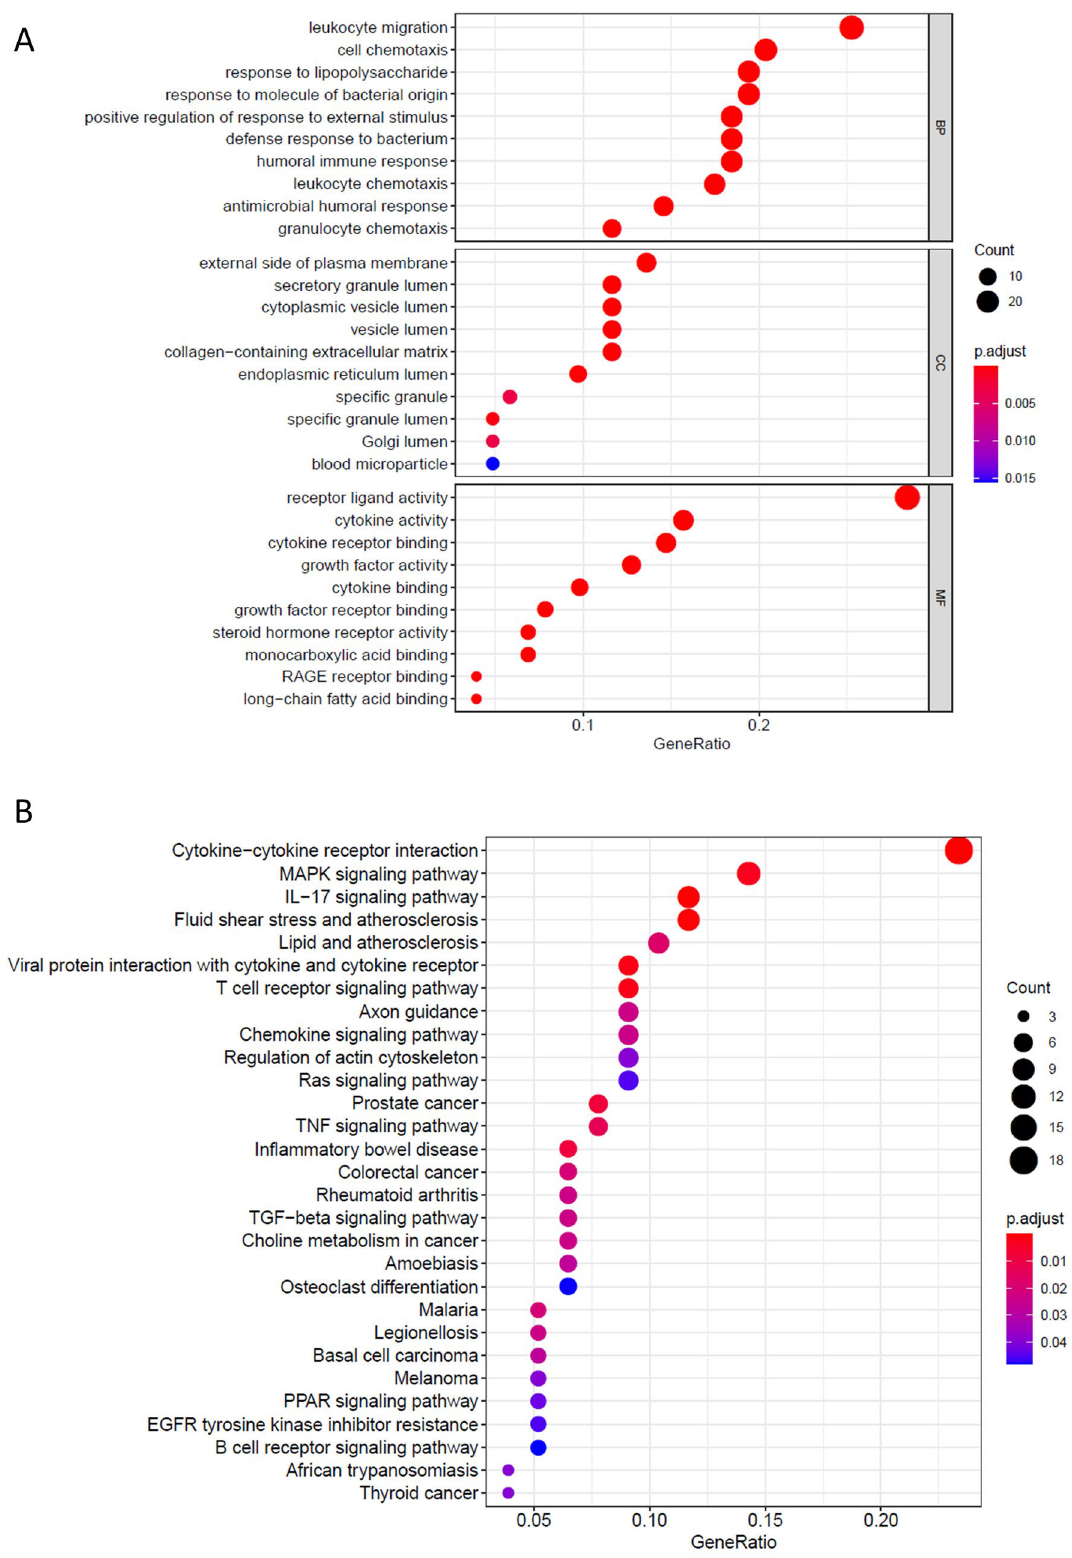
Figure 3. GO function analysis and KEGG pathway analysis. ( A ) GO functional enrichment analysis of the immune-related DEGs. ( B ) KEGG functional enrichment analysis of the immune-related